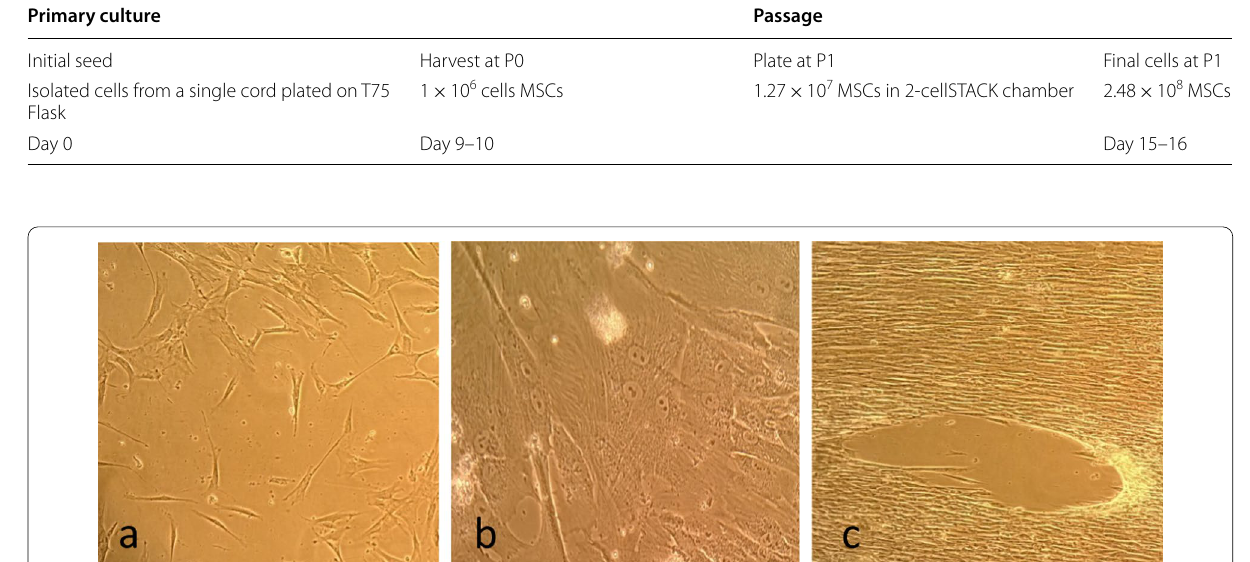
Fig. 2 Cord tissue-derived cells on ( a ) 7 days ( b ) 10 days ( c ) 20 days, respectively, as observed under 20X magnification under inverted microscope Olympus